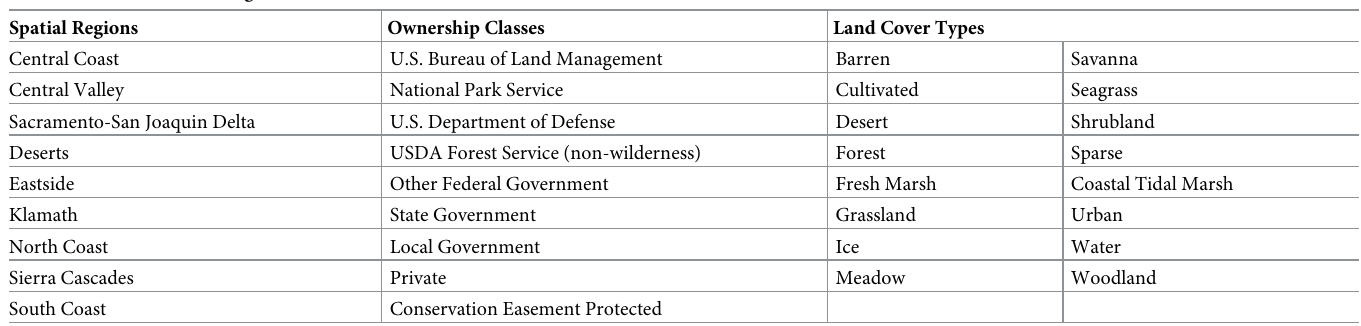
Table 1. CALAND land categories.